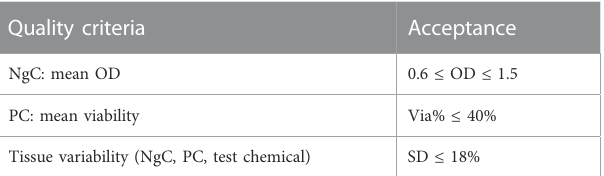
TABLE 2 Quality criteria de fi ned in OECD TG